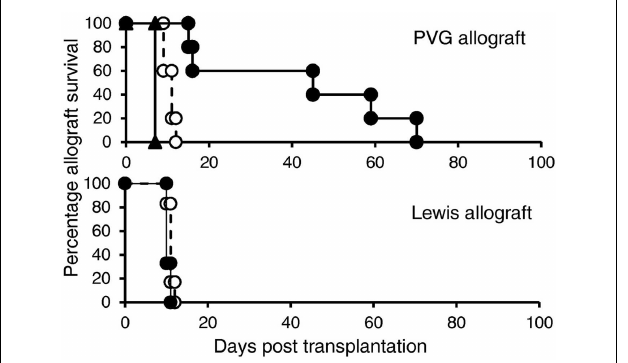
FIGURE 6 | In vivo suppression of allograft rejection byTs1 cells re-cultured with PVG stimulators and rIL-12p70 .Ts1 cells generated by culture of CD4 + CD25 + T cells with PVG alloantigen and rIL-2 for 3days were re-cultured with rIL-12p70 and PVG alloantigen for 4days to produceTh1-like Treg ( • ). 5 × 10 6 of theTh1-likeTreg were given 3days after grafting, as we expected by that time the rejection response producing IL-2, IL-12p70, and IFN- γ would be induced in the host, as described (32).These delayed PVG (top panel) but not third party Lewis (bottom panel) allograft rejection compared to normal rejection controls ( ◦ ) ( n = 5/group) ( p < 0.01). In comparison, 5 × 10 6 Ts1 cells that had been re-cultured with rIL-2 and PVG for 4days ( (cid:78) ) did not delay rejection ( n = 4), this demonstrated re-culture of Ts1 cells with rIL-12p70 was required to induce potent alloantigen-specific Treg that could suppress